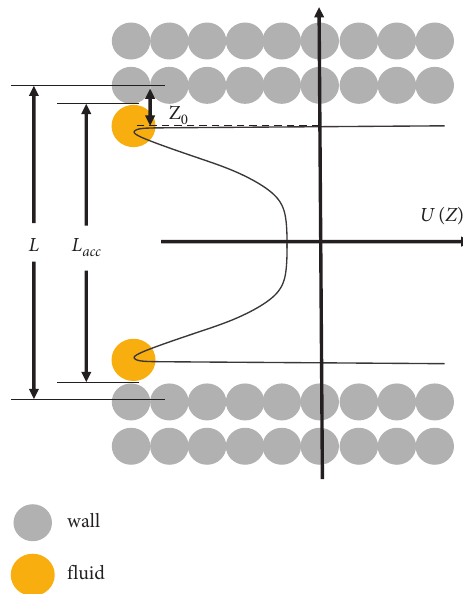
Figure 1: Definition of the accessible pore width L ′ and the physical pore width L .